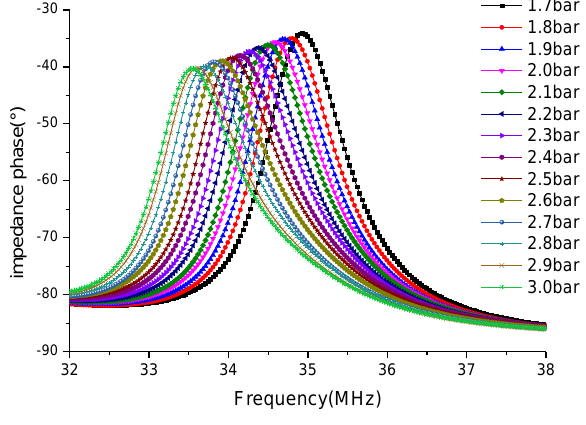
Figure 5. Readout signals of different gas pressures at 20 °C.